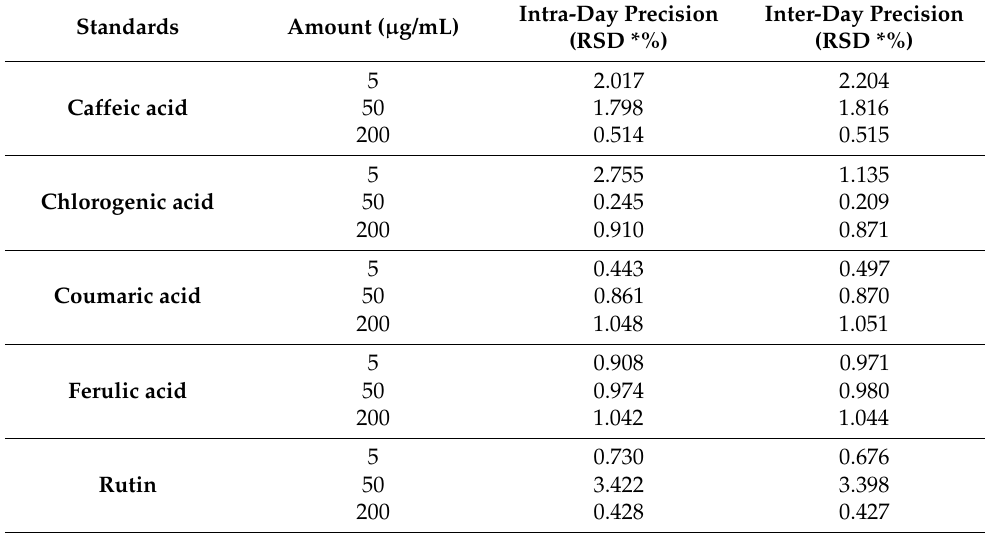
Table 3. Precision data of the method.